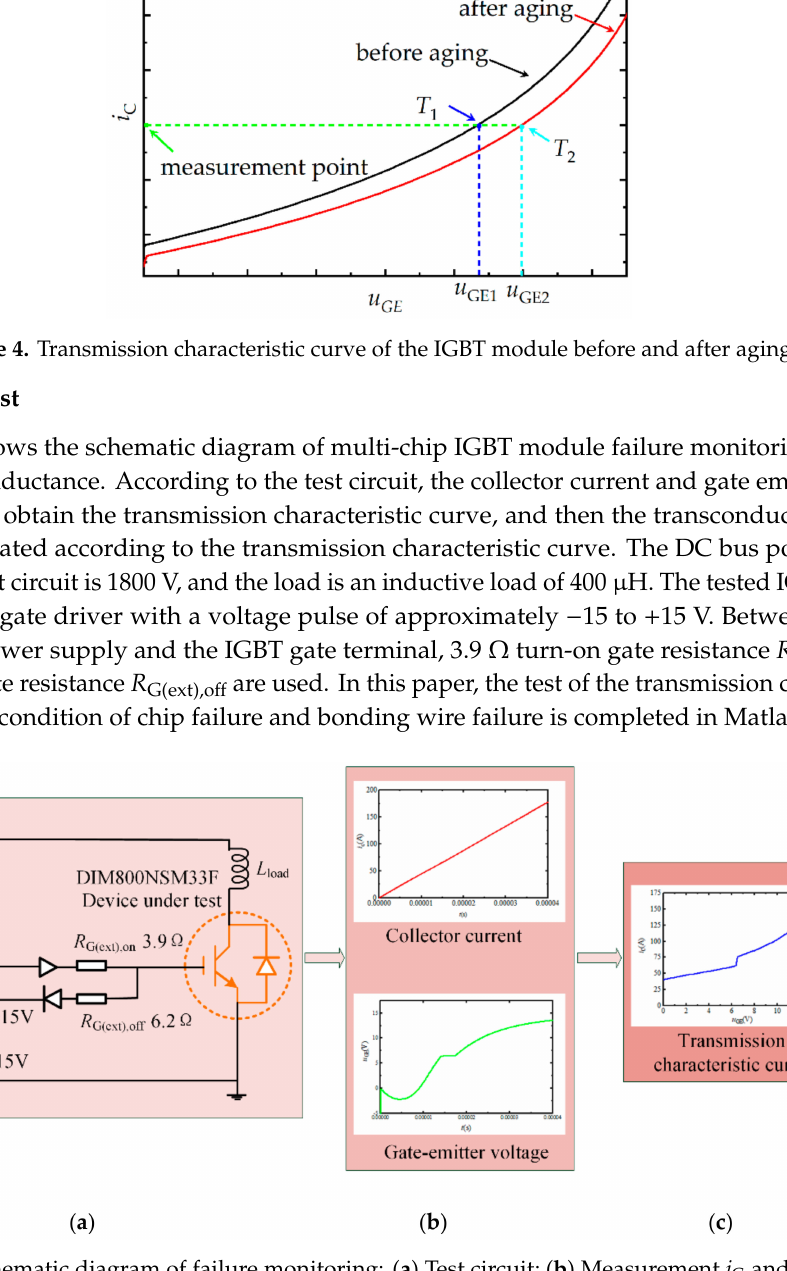
Figure 5. Schematic diagram of failure monitoring: ( a ) Test circuit; ( b ) Measurement i C and u GE ; ( c ) Acquisition of transmission characteristic